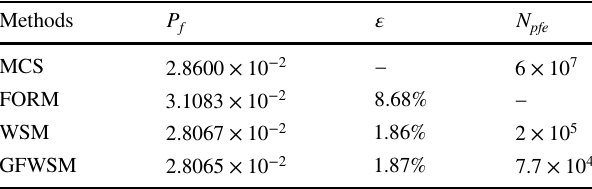
Table 3 Distribution parameters of the random variables in example 2 Random variables Distribution